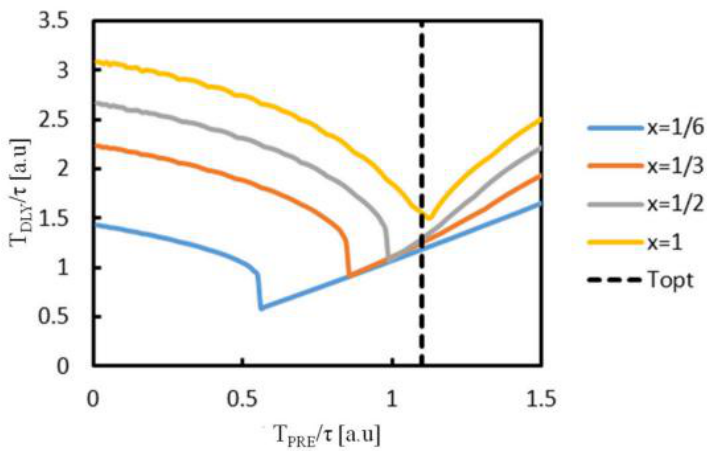
Figure 9. T DLY vs. T PRE at x = 1/6, 1/3, 1